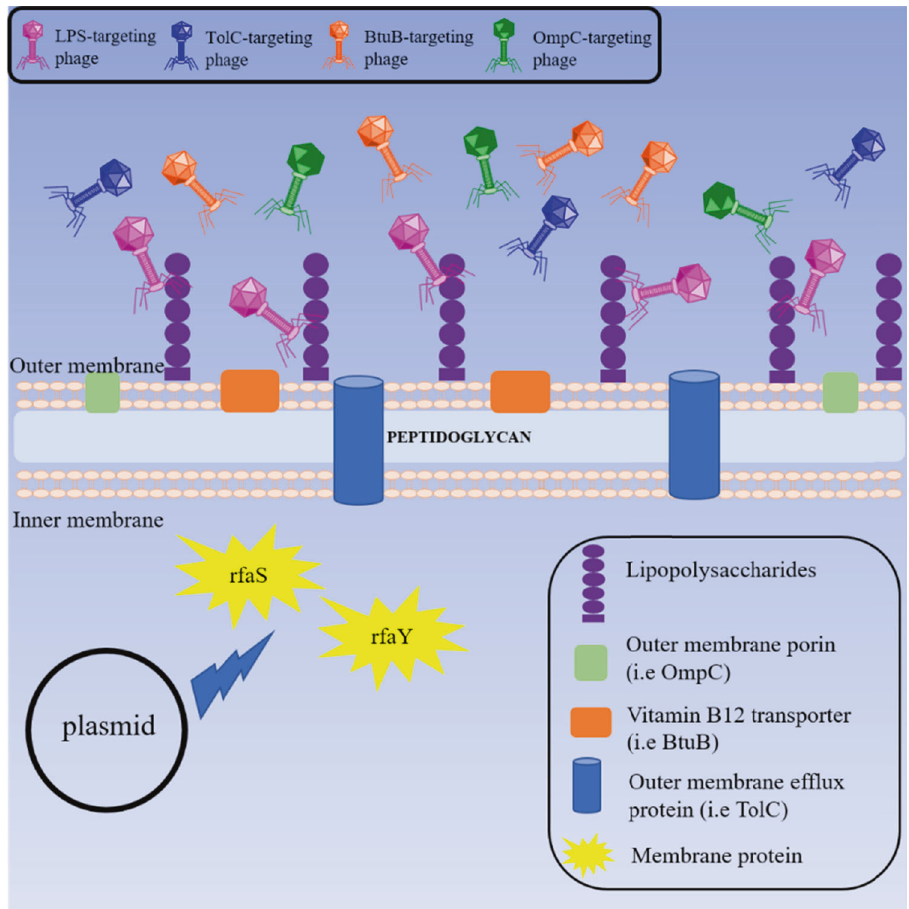
Fig. 5 Schematic diagram illustrating the effect of plasmid that indirectly interferes with the expression of cell membrane protein RfaS and RfaY, related to biogenesis of LPS. Changes in the expression of these membrane proteins indirectly affect the expression of LPS cell surface receptors, thereby attracting phage that potentially utilize LPS as cell surface